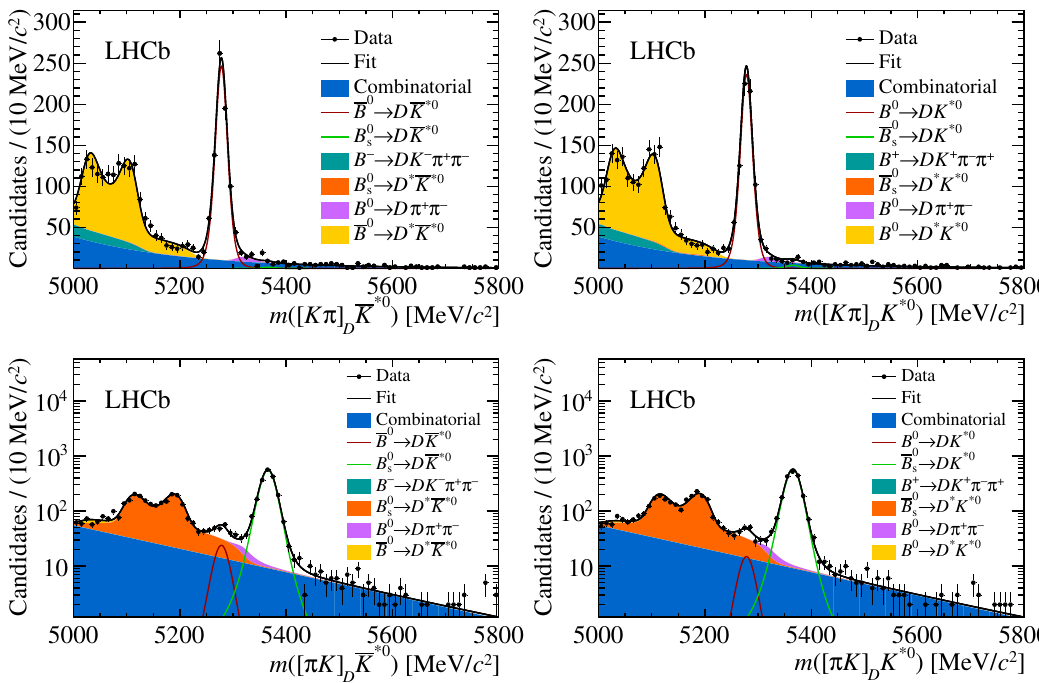
Figure 3 . Invariant-mass distributions (data points with error bars) and results of the (cid:12)t (lines and coloured areas) for the two-body ADS modes (top left) B 0 ! D ( K (cid:0) (cid:25) + ) K (cid:3) 0 , (top right) B 0 ! D ( K + (cid:25) (cid:0) ) K (cid:3) 0 , (bottom left) B 0 ! D ( (cid:25) (cid:0) K + ) K (cid:3) 0 and (bottom right) B 0 ! D ( (cid:25) + K (cid:0) ) K (cid:3) 0 . The bottom distributions are shown on a logarithmic scale.